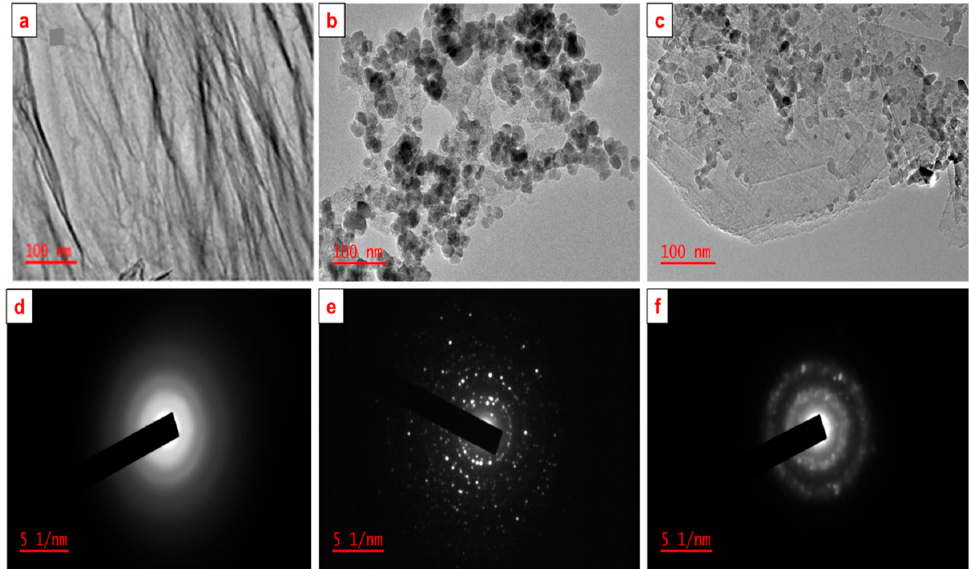
Figure 3. TEM images of RGO nanosheets ( a ), MnO 2 nanoparticles ( b ) and the MnO 2 @RGO nanocomposite ( c ), with cor- responding SAED patterns ( d – f ). posite ( c ), with corresponding SAED patterns ( d – f